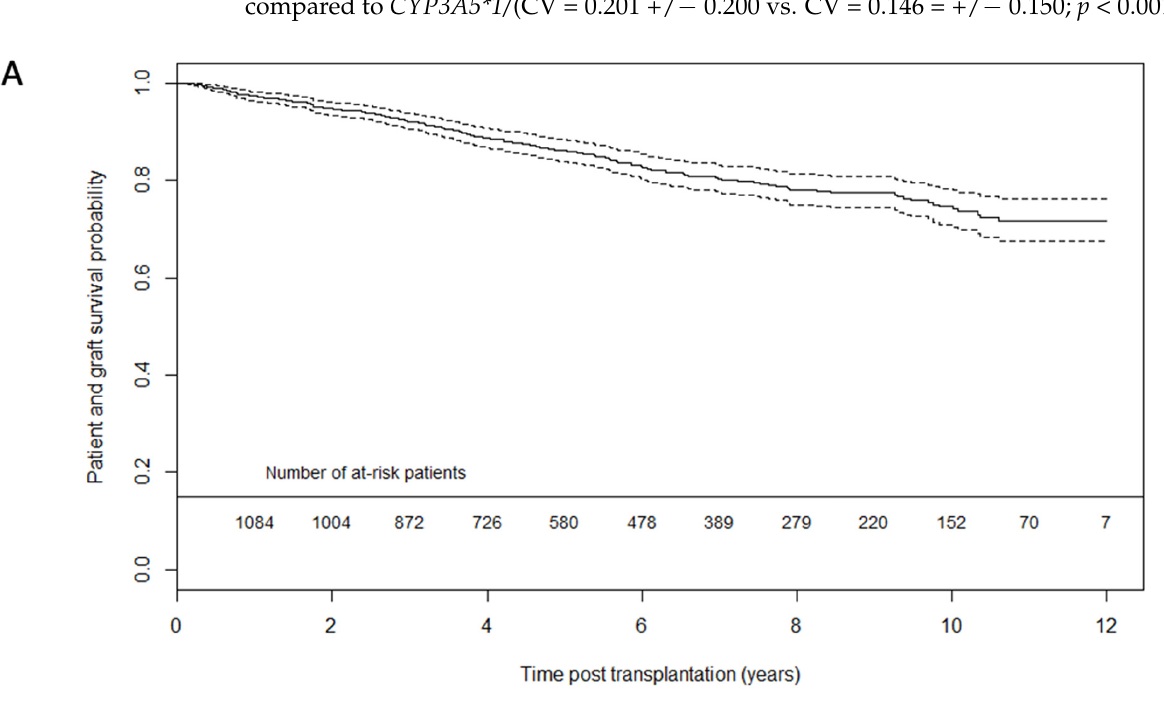
Figure 1. Patient graft survival unadjusted curves using the Kaplan Meier estimator ( A ) on whole population ( A ) and according to CYP3A5 genotype ( B ). Dashed lines represent 95% confidence interval. n = 1114 patients.